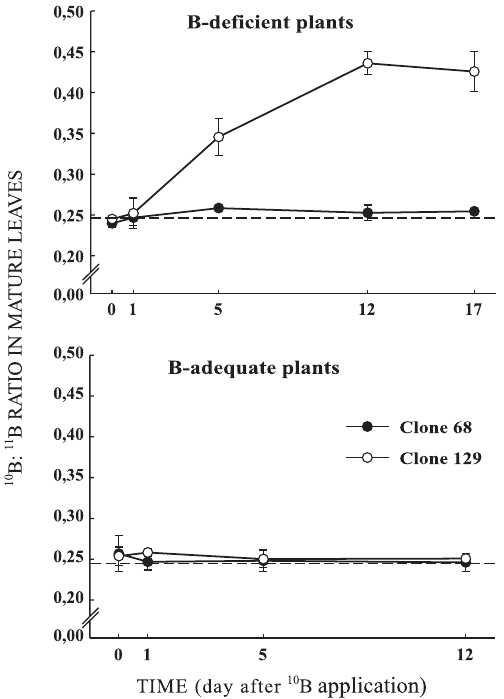
SRM-951.Figure 4. Isotope ratio of 10 B: 11 B in the mature leaves over the course of time after the application of 10 B to one mature leaf of B-deficient and adequately supplied plants of two eucalypt clones. The dashed line (----) represents the natural abundance of 10 B: 11 B = 0.247 of the certified standard NIST